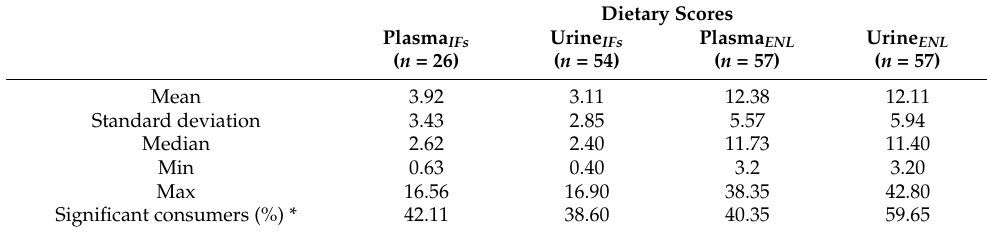
Table 2. Dietary scores for each phytoestrogen measured.